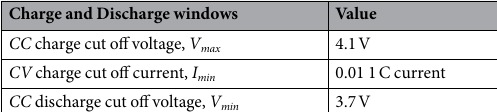
Table 2. Operating conditions used in the simulations.